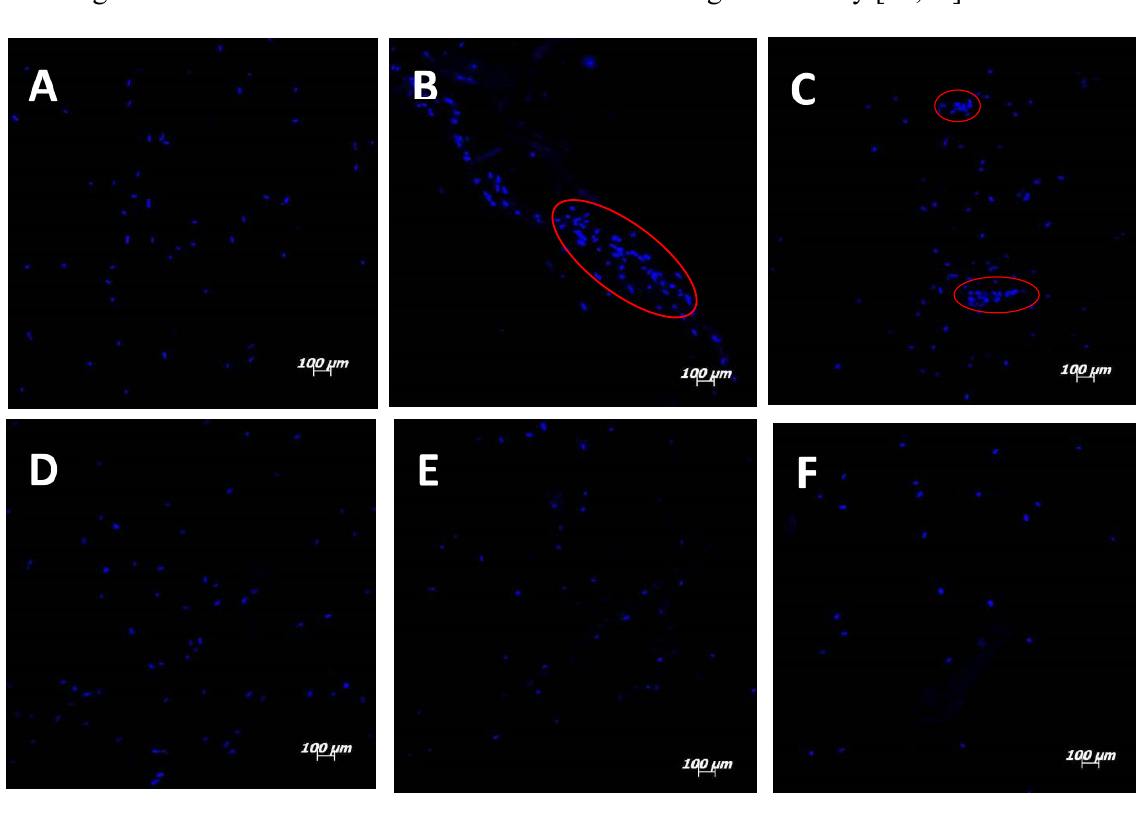
Figure 2. Fluorescence confocal images (100× magnification) of cells on electrospun scaffolds: ( A ) PLLA; ( B ) PLLA after hydrolysis and collagen incorporation with EDC; ( C ) PLLA after aminolysis and collagen incorporation with GTA; ( D ) PLLA/collagen electrospun by blending; ( E ) PLLA/collagen electrospun by co-electrospinning and using HFP as the collagen solvent; and ( F ) PLLA/collagen electrospun by co-electrospinning and using acetic acid solution as the collagen